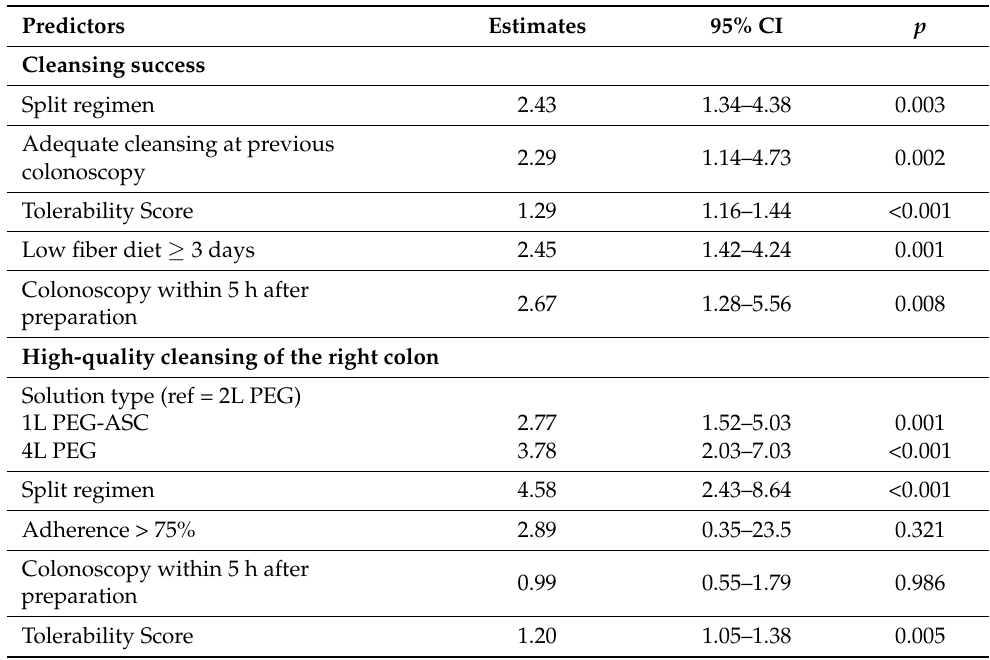
Table 3. Logistics multiple regression model estimates for overall cleansing success and high-quality cleansing of the right colon in the